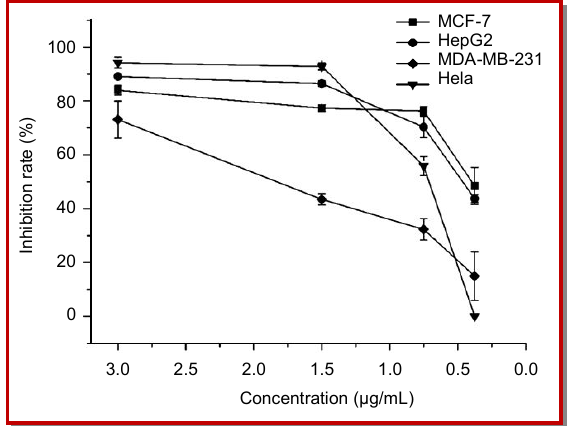
Figure 2: The inhibition rate of cell lines after treatment for 24